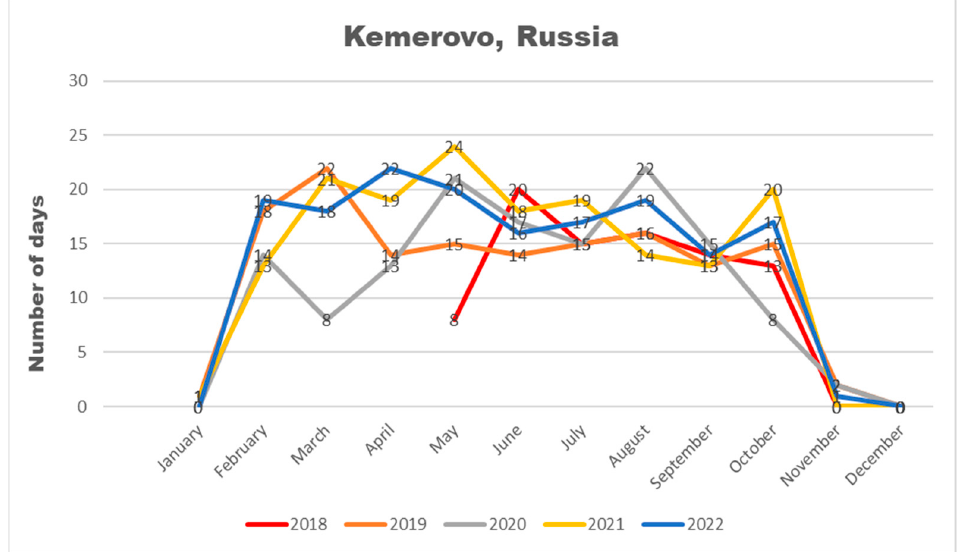
Figure 3. Number of days with methane data available from TROPOMI, Kemerovo region, Russia.